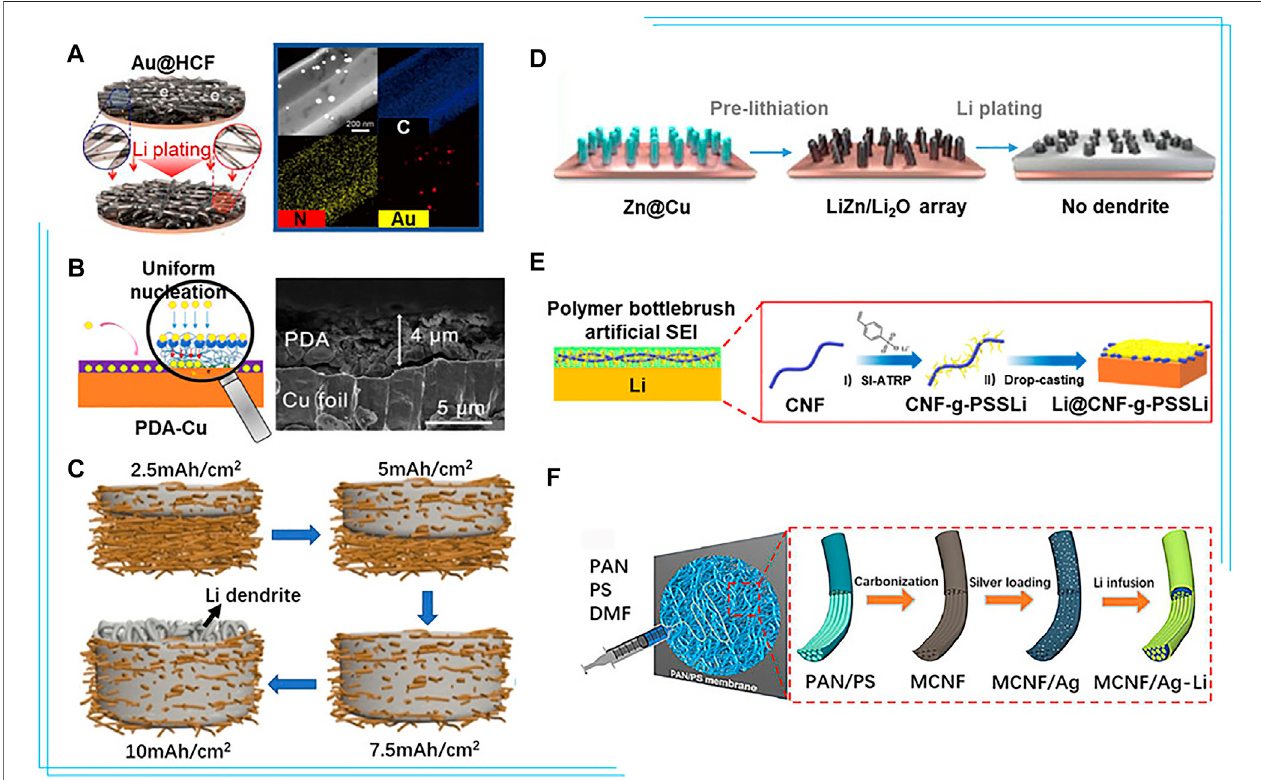
FIGURE2|(A) SchematicrepresentationoflithiumplatingonthebareontheAu@hollowcarbon fi berelectrodesandSTEMimageofAu@hollowcarbon fi berand C, N, and Au EDS elemental mapping (Kim et al., 2021). (B) Diagram of the mechanism of polydopamine-induced Li deposition and the SEM images of the PDA-Cu foil (cross view) (He et al., 2019). (C) Schematic illustration of the lithium plating in the 3D Cu nanowire network current collector at different charging states (Lu et al., 2016). (D) Schematic illustration of lithium plating on the lithiated ZnO@Cu electrode (Wang G. et al., 2019). (E) Schematic illustrations of the evolution of polymer bottlebrush arti fi cial SEI during fast charging fi lms and the preparation of CNF-g-PSSLi (Zeng et al., 2021). (F) Schematic illustration of the preparation process of multichannel carbon fi bers/Ag-Li composite anodes (Yu et al., 2020). Reproduced with permission from the Elsevier and American Chemical